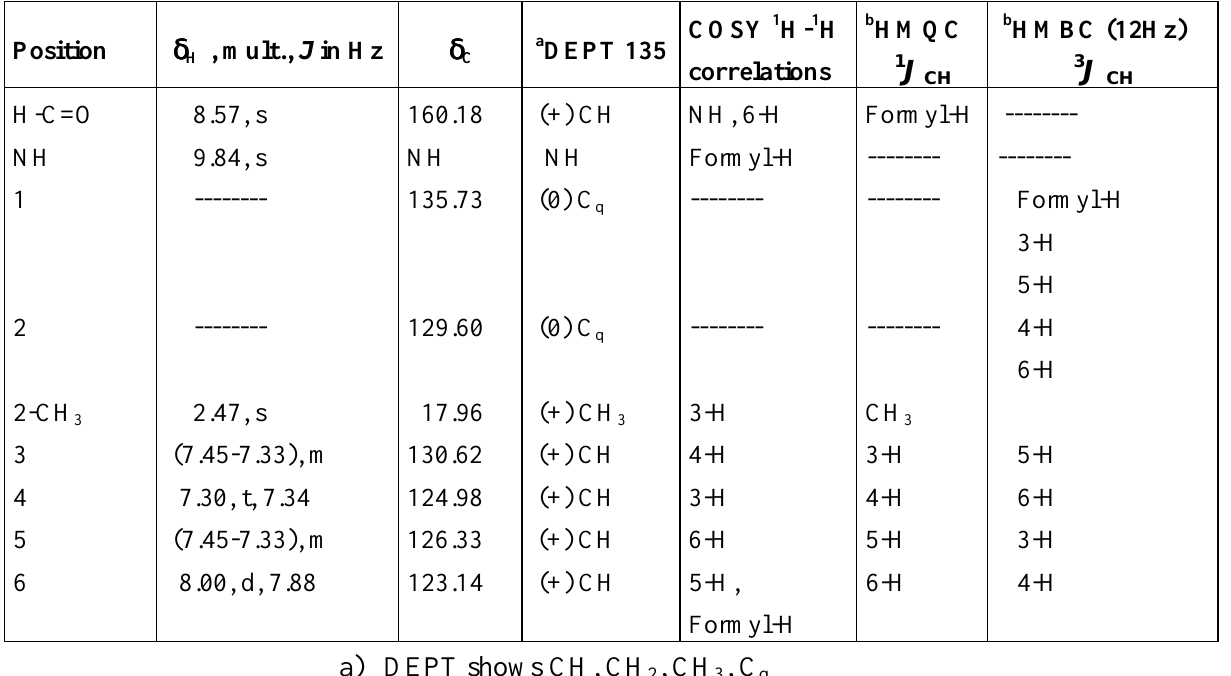
Table 1. 1 H(400 MHz) and 13 C NMR (100MHz) Spectral Data for cis -2 in DMSO- d